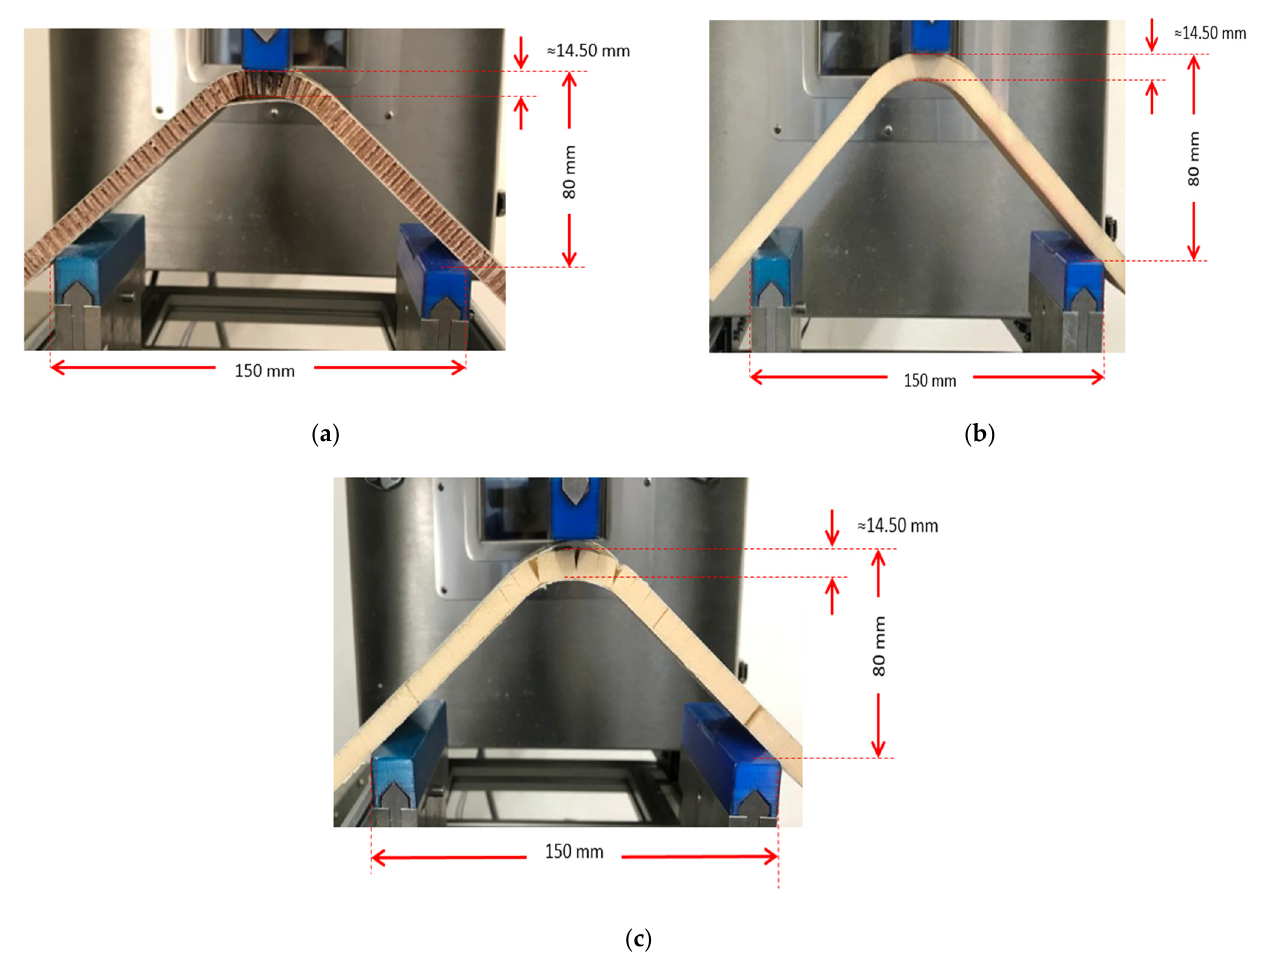
Figure 7. Pictures of the three ‐ point bending test performed to: ( a ) GF/HC/GF, ( b ) GF/Foam/GF, ( c ) GF/Gridding foam/GF. The pictures present the damages that occurred during the test.